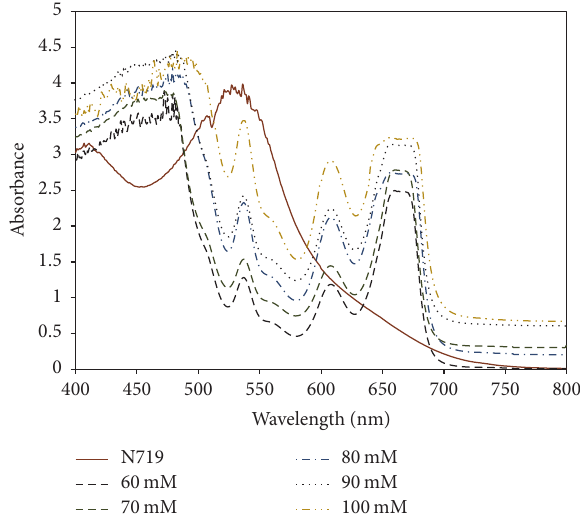
Figure 1: Absorption spectra of N719 and chlorophyll